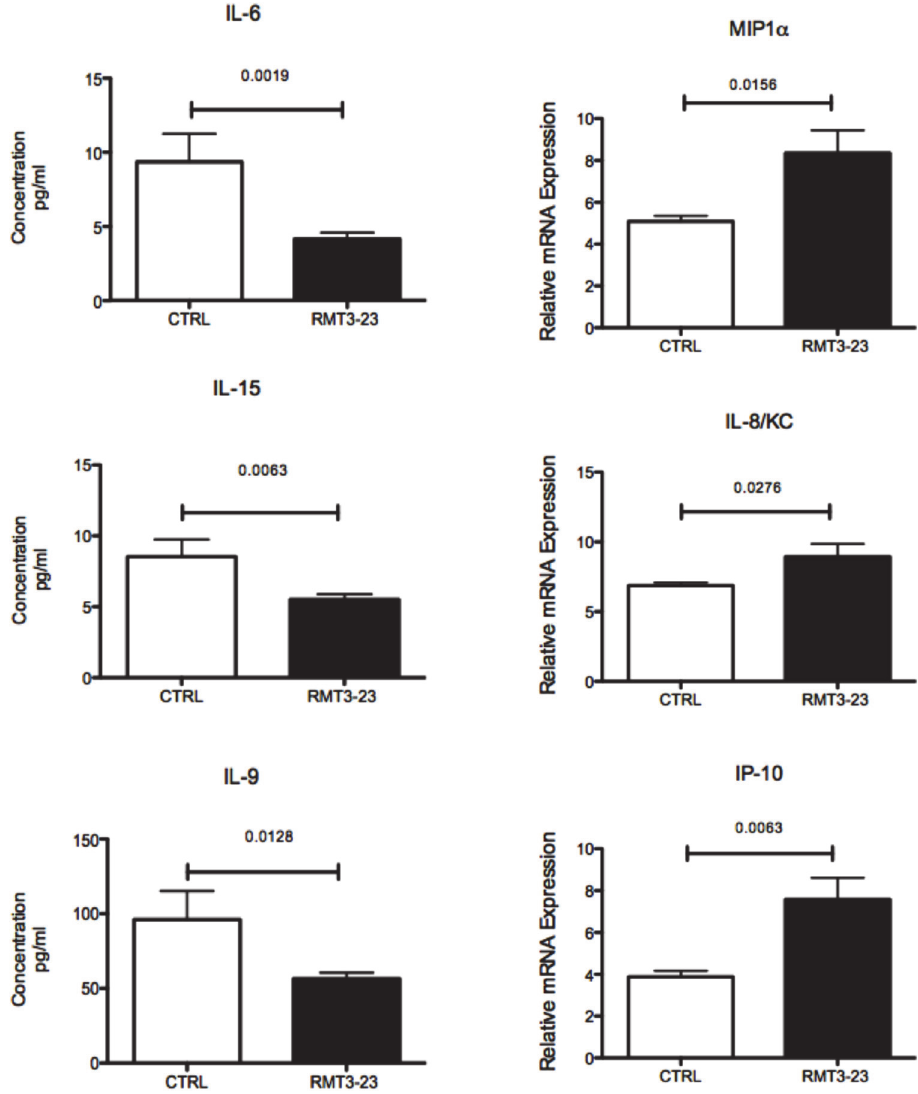
Fig 2. Effect of RMT3-23 treatment on the cytokine and chemokine milieu in the placenta and on the uNK cell population size of pregnant CBA mice between G.D 10.5 to 12.5 that were allogeneically mated to C57BL/6 males. A significant decrease in IL-6, IL-15 and IL-9 concentrations and a significant increase in MIP1 α , IL-8/KC and IP-10 mRNA expression is observed in the placental homogenate from mice treated with RMT3-23 in comparison to the control group. Data are presented as mean ± SEM. Statistical analysis was done using unpaired t test. However, there was no significant change in the number of uNK cells (CD3- CD122+ NK1.1- and DX5-) between control and treated groups following treatment with RMT3-23. Data are presented as mean ± SEM and are representative of at least 3 experiments. Statistical analysis was done by one-way analysis of variance (ANOVA) using Kruskal-Wallis